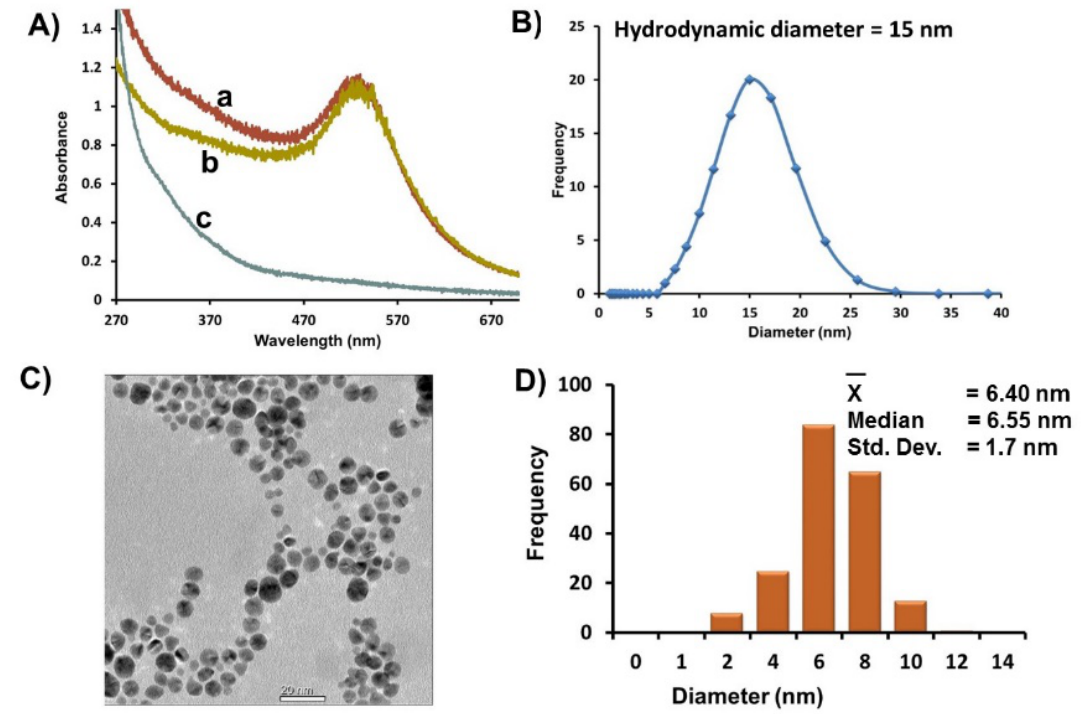
Figure 1. ( A ) Representative UV-Vis spectra of Au-GSH (a) before purification, (b) after purification by ultracentrifugation, and (c) of a brown permeate solution containing smaller nanoparticles removed after ultracentrifugation. ( B ) Average hydrodynamic diameter based on DLS measurements of Au-GSH. ( C ) Representative TEM image. ( D ) Distribution histogram of Au-GSH (Scale bar = 20 nm). All samples were in 10 mM sodium phosphate buffer pH